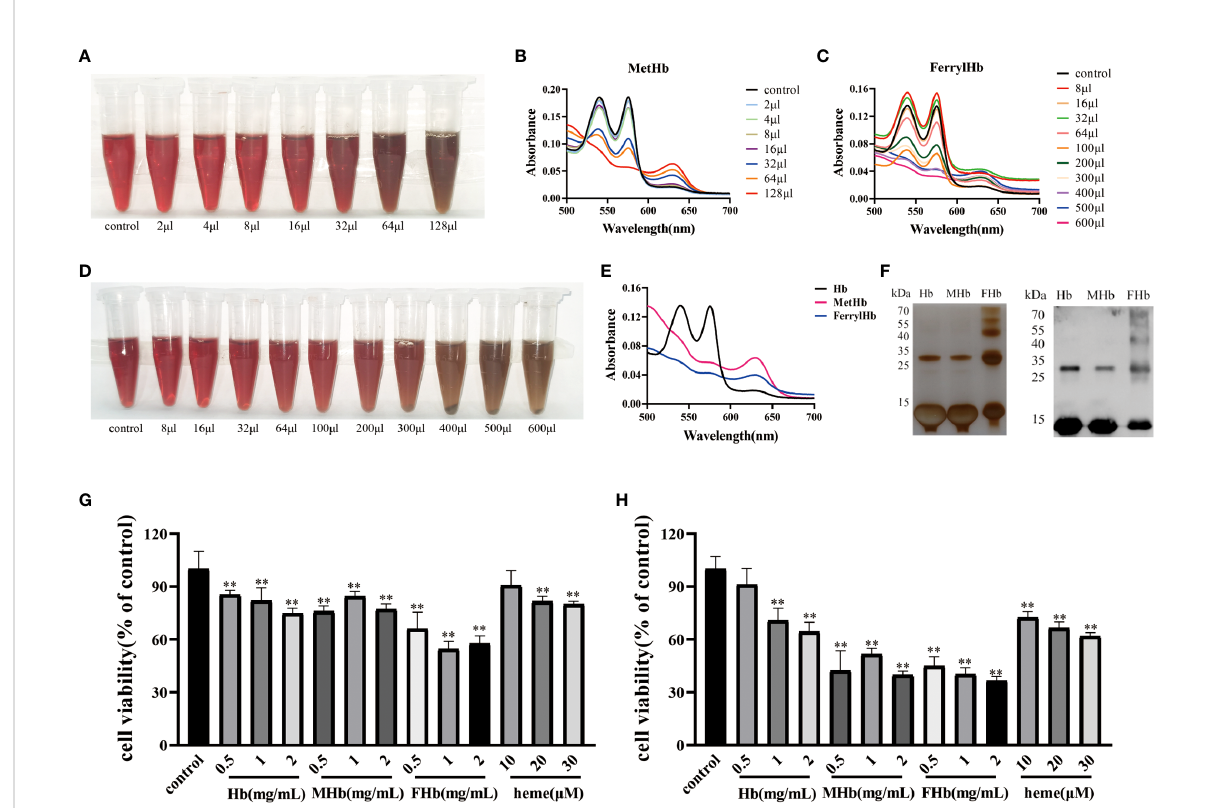
FIGURE 4 The stimulation of Hb caused cell damage. (A, B) The MetHb was prepared by incubating 30 min with incremental K 3 Fe(CN) 6 at 25°C. The color changes were recorded and spectroscopic carried out to analyze the change of spectrum curve. (C, D) The FerrylHb was prepared by adding 3% H 2 O 2 and incubating at 37°C for 1 h. The color change was recorded and spectroscopic carried out to analyze the change of spectrum curve. (E) The changes of the spectroscopic of Hb, MetHb and FerrylHb were compared. (F) Hb, MetHb and FerrylHb were silver stained by SDS-PAGE. (G, H) The survival rate of L8824 cells under stimulation of different concentrations of Hb, MetHb and FerrylHb for 12h (G) and 24h (H) . The data were the mean values of three independent experiments, expressed as mean ± SEM (**P <